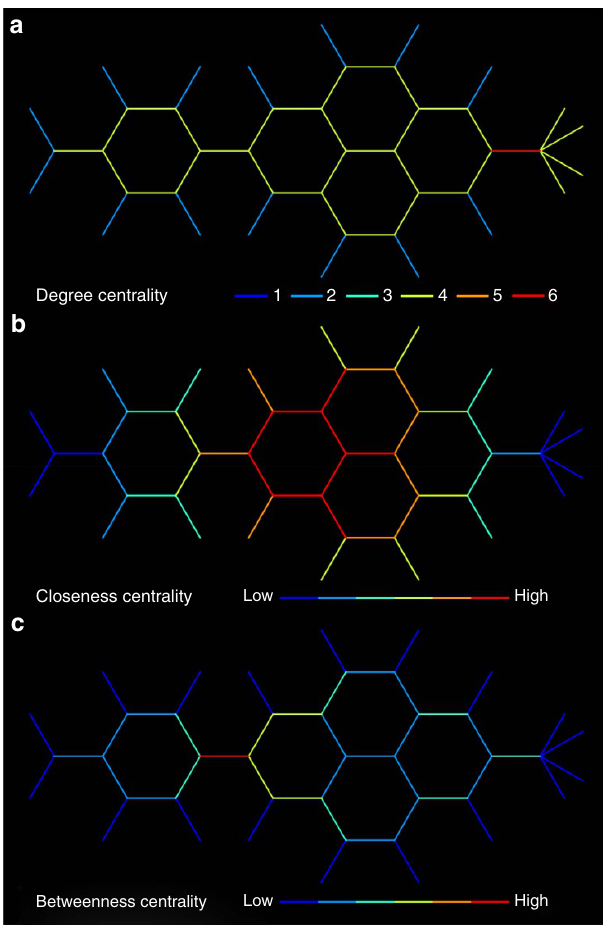
Figure 1 | Illustration of the three centrality measures in a sample network. The network was chosen to illustrate how the three measures of centrality record different properties of the network. Note each measure identifies different streets as having the highest value. ( a ) The highest degree centrality street reflects the fact that this street has six streets connected to it. ( b ) The highest closeness centrality streets reflect the fact that these streets are topologically closest to all other streets in the network. ( c ) The highest betweenness centrality street indicates that this street would be travelled most frequently when travelling from any one street to